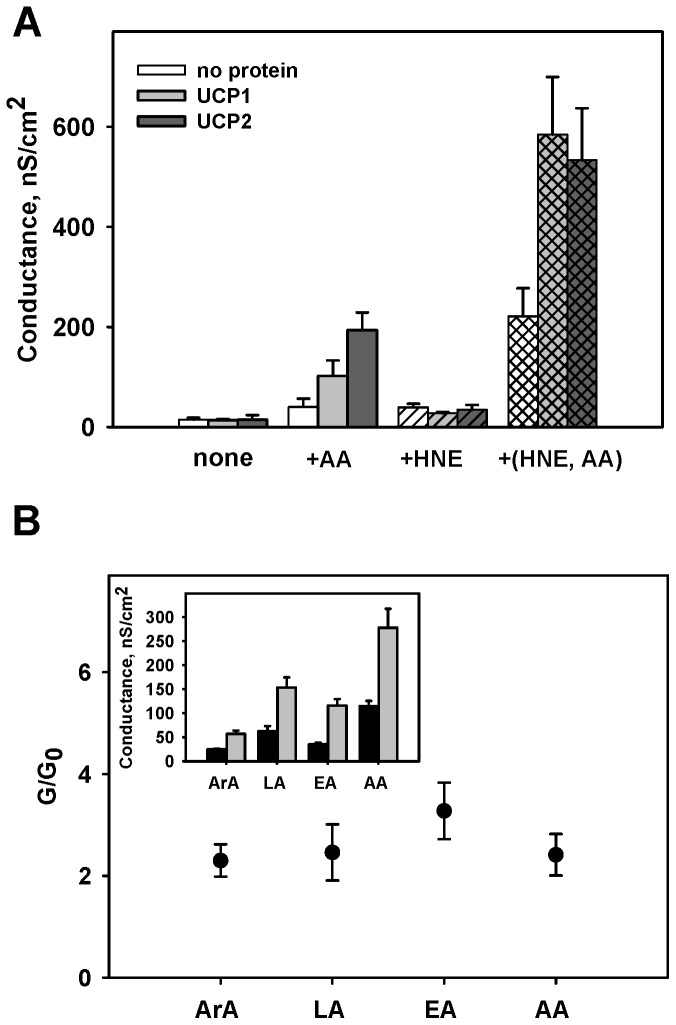
The effect of 4-hydroxy-2-nonenal on membrane conductance (G).A. Influence of HNE and/or arachidonic acid (AA) on G in the absence (white bars) and presence of UCP1 (grey bars) or UCP2 (dark grey bars). The concentrations of E. coli polar lipid, UCP1, UCP2 and HNE were 1 mg/ml, 5.5 µg/(mg of lipid, charge 9), 4.7 µg/(mg of lipid) and 0.86 mM respectively. AA was directly added at a concentration of 15 mol% to the lipid phase prior the membrane formation. The buffer solution contained 50 mM K2SO4, 25 mM TES 0.6 mM EGTA at pH 7.4 and T = 32°C. HNE was directly added to the buffer solution. Data points represent mean ± standard deviation from 3–5 independent experiments. B. Comparison of membrane conductance ratios in the presence (G) and absence (G0) of 0.64 mM HNE for arachidic (ArA, 20:0), linoleic (LA, 18:2, ω6), eicosatrienoic (EA, 20:3, ω3) and arachidonic acid (AA, 20:4, ω6). Inset. Membrane conductance in the presence (grey bars) and absence (black bars) of HNE. Membranes from E. polar lipid were reconstituted with 15 mol% FA and 7 µg UCP1/(mg of lipid) (charge 33). The buffer solution contained 50 mM Na2SO4, 10 mM Tris, 10 mM MES, 0.6 mM EGTA, at pH 7.4 and T = 32°C. Data represent mean ± standard deviation from at least 3 independent experiments.